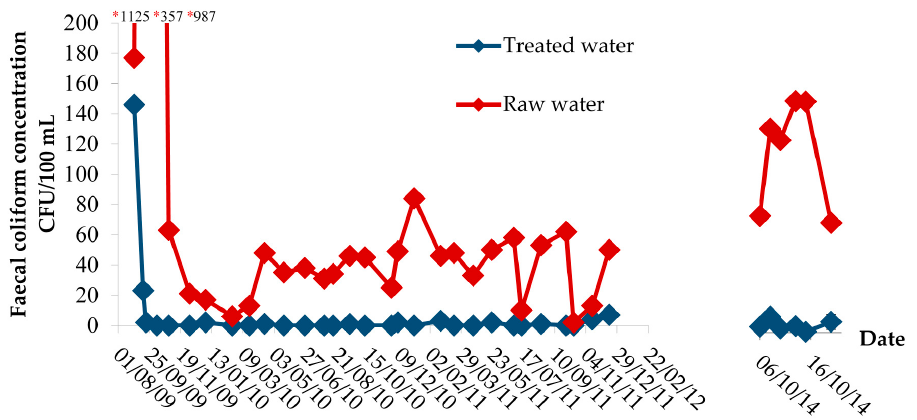
Figure 4. Faecal coliform concentration of raw and treated water measured 2009–2011 and 2014.